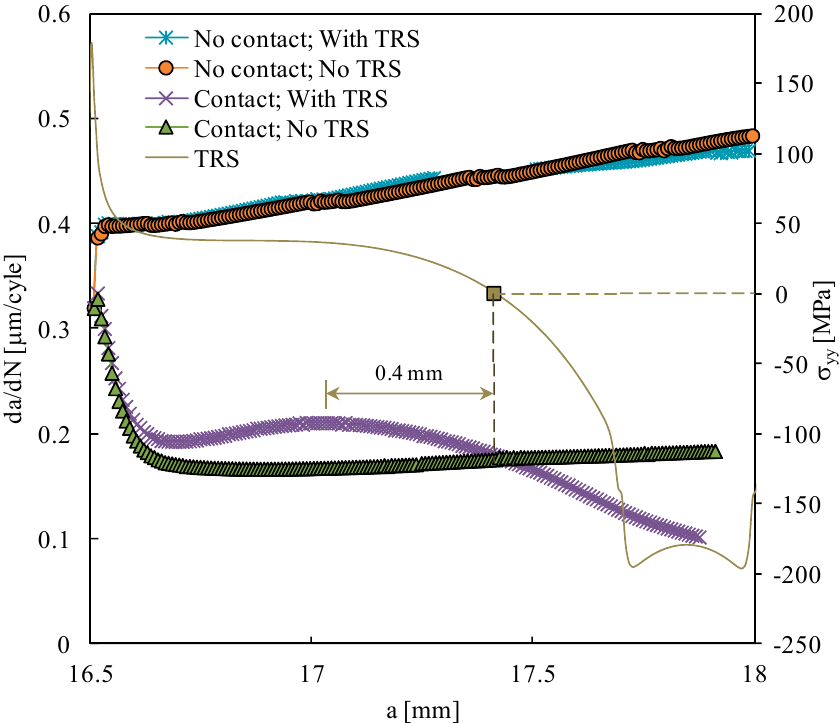
Figure 5. Fatigue crack growth rate versus the crack length for the elastic residual stresses (case A).